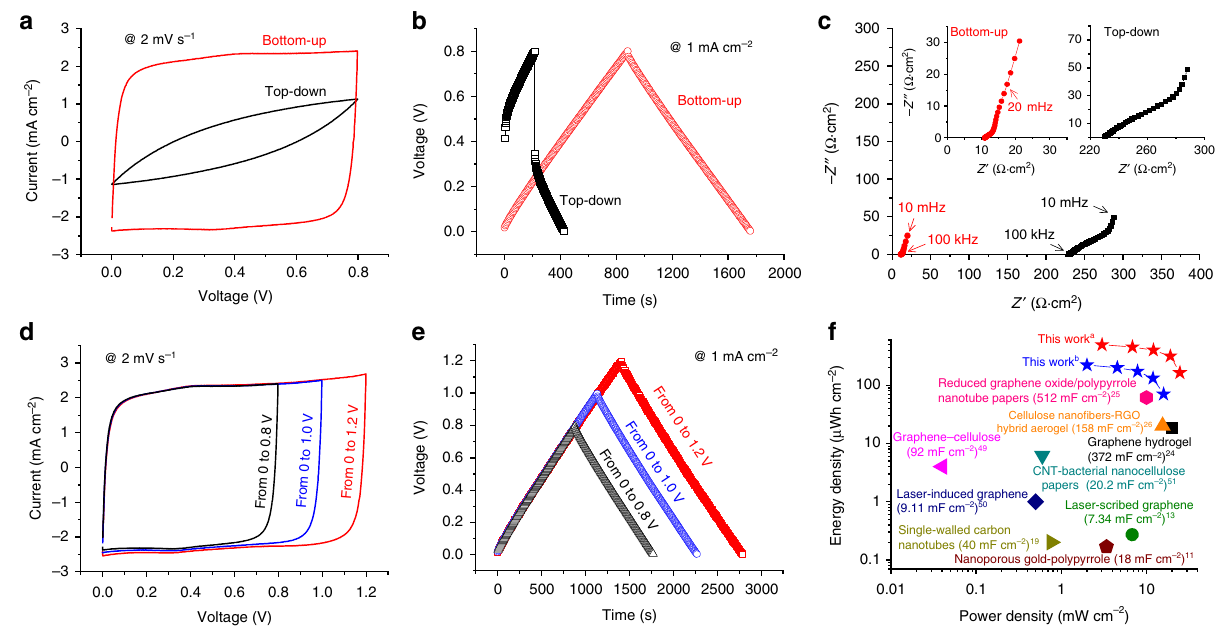
Fig. 4 Electrical performance of FSSCs formed using 500 μ m thick PEDOT/PSS-WMCNT electrodes. a CV, b GCD pro fi les, and c Nyquist plots (100 kHz to 10 mHz) of the top-down and bottom-up designs. Note that the inset is the plot for the bottom-up in fi lled FSSC. d CV and e GCD curves over different potential windows for a FSSC formed from bottom-up in fi lled 500 μ m thick PEDOT/PSS-MWCNT electrodes. f Areal Ragone plot (per cm 2 of the FSSC device). This work a and this work b refers to the bottom-up in fi lled FSSCs with an electrode thicknesses of 500 μ m tested over potential windows of 0 to 1.2 V and 0 to 0.8 V,